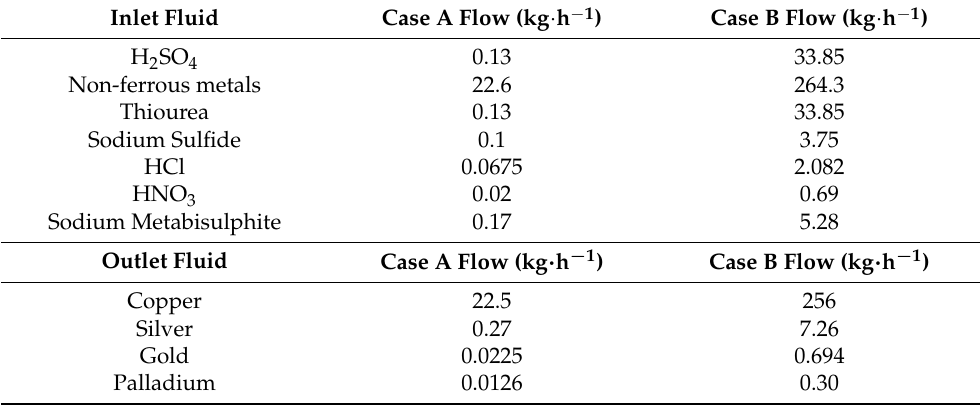
Table 3. Calculated flow rates and compositions of the inlet and outlet streams of the second part of the